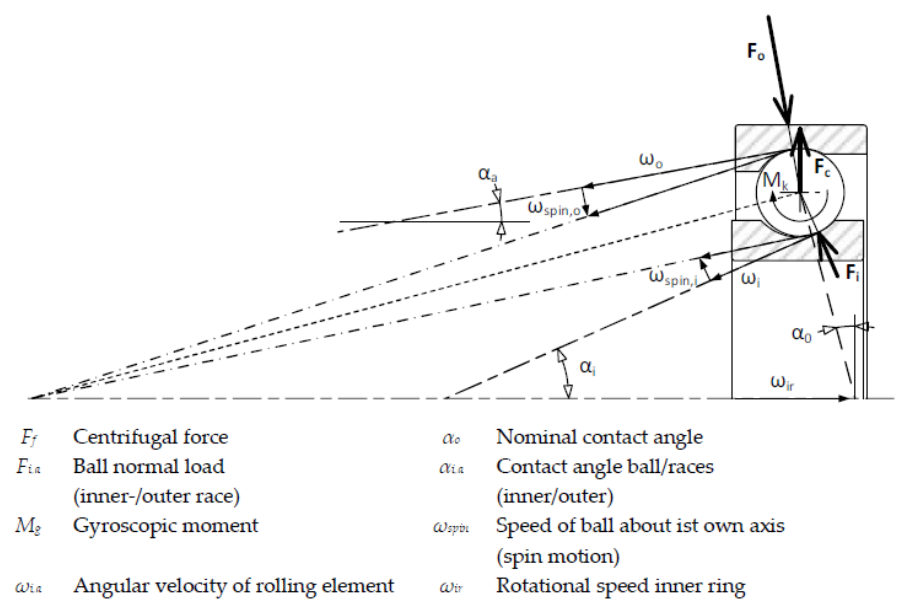
Figure 15. Spin-/Roll ratio in an angular contact ball bearing at high speed.